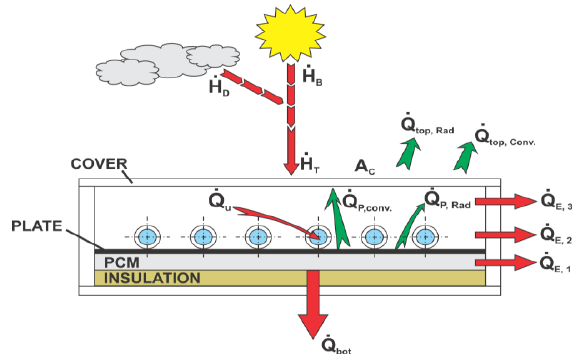
Figure 1. Heat transfer terms involved in solar